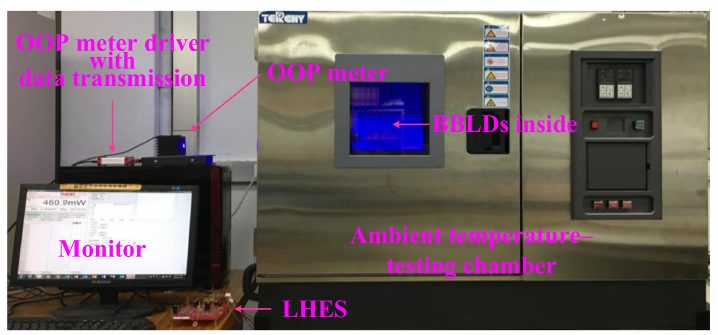
Figure 24. Practical measurement system.